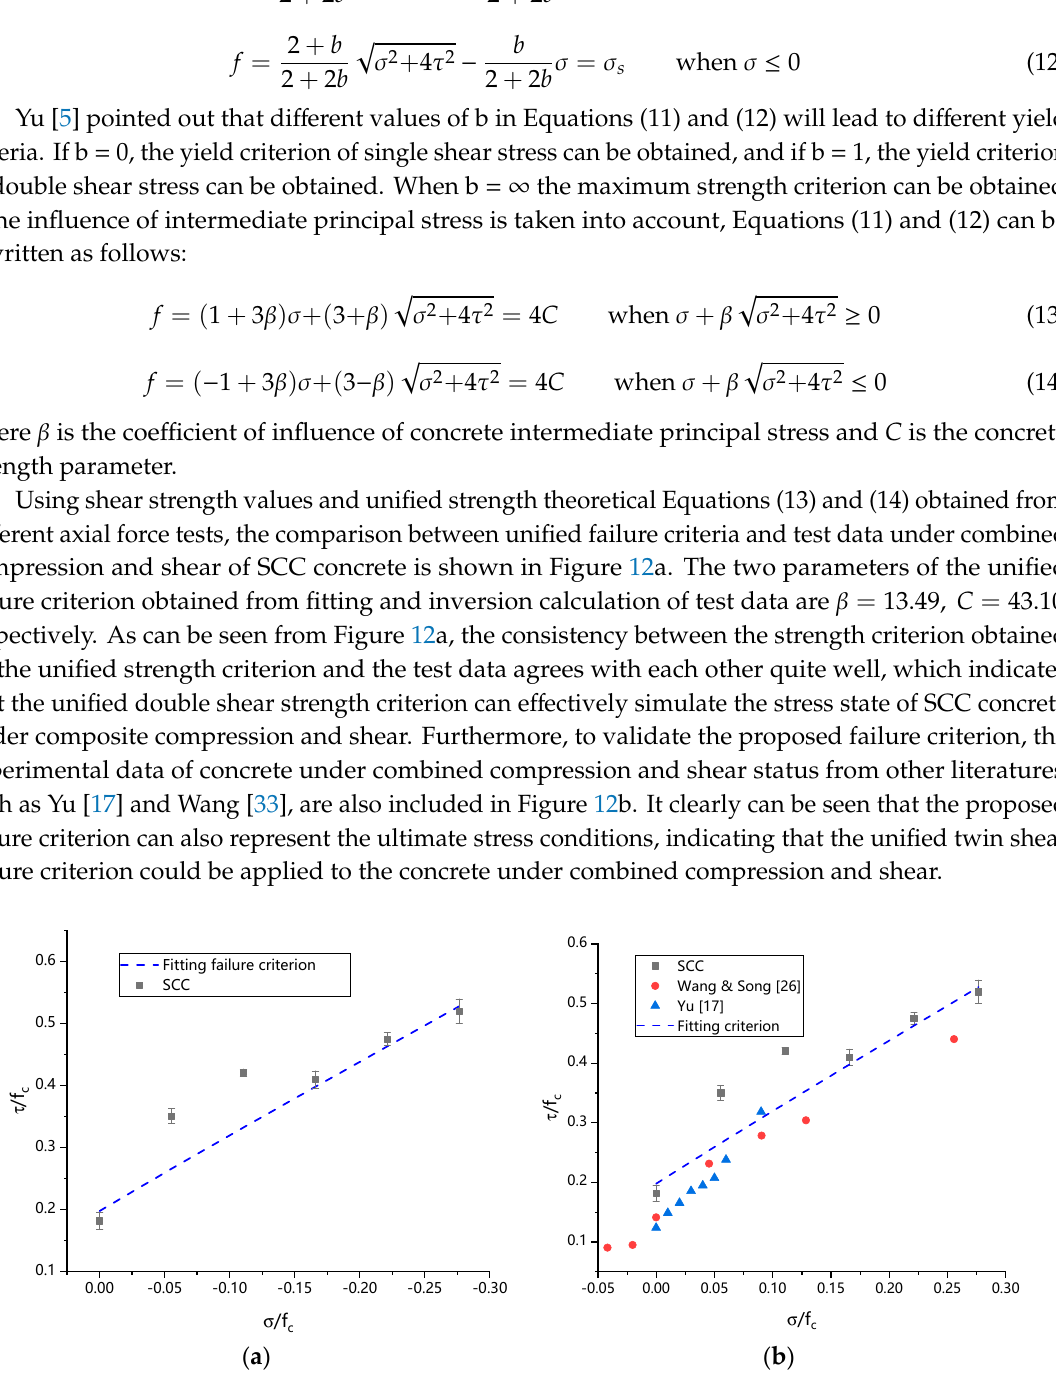
Figure 12. The unified twin shear failure criterion of SCC: ( a ) Failure criterion of twin shear strength theory; ( b ) Comparison of the proposed failure criterion with multiple experimental data.